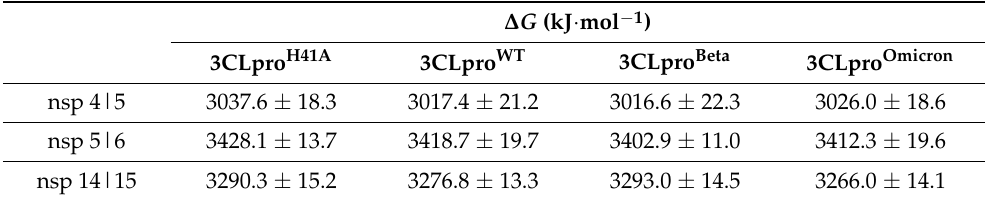
Table 1. Perturbation free energy (FEP) estimated by molecular dynamics. Binding free energies ( ∆ G in kJ · mol − 1 ) between different substrates and different 3CLpro.